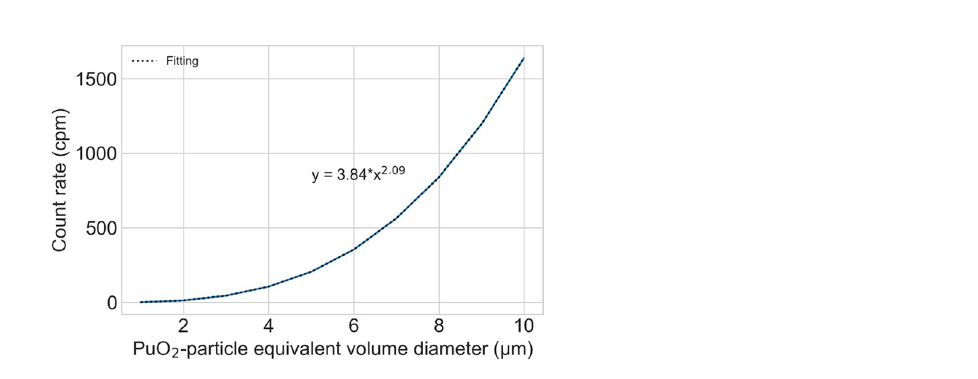
Figure 7. CF curve for the conversion of the measured alpha counts into d e calculated using the Monte Carlo